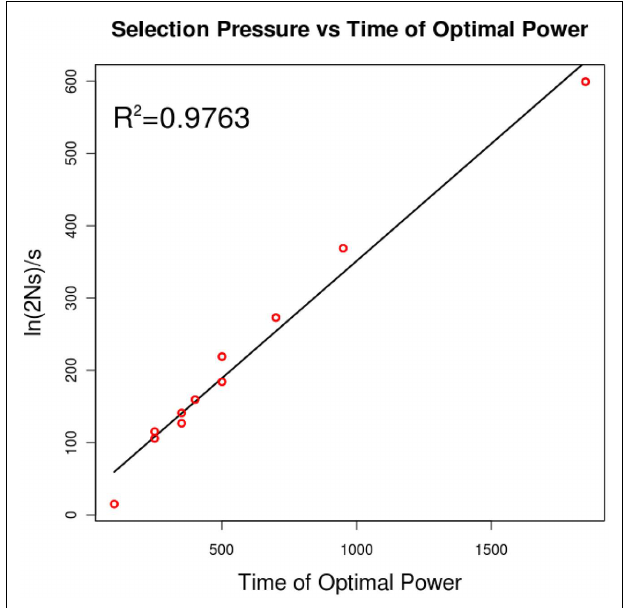
FIGUREA1 |The relationship of selection pressure to the time of optimal power. Campbell (2007) has shown that, under strong selection, the expected time to fixation can be approximated by ln (2Ns)/s.This plot shows that, for a selection pressure s, the time that yields optimal power is linearly related to this